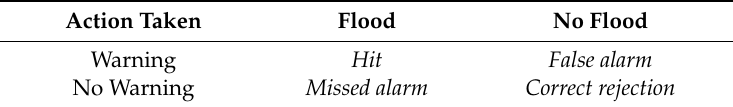
Table 3. The relationship between warnings and